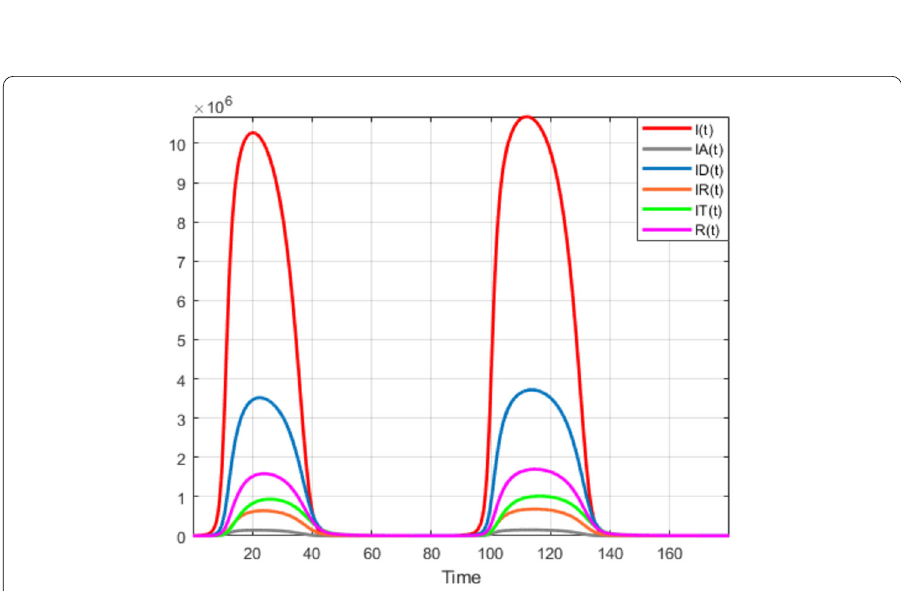
Figure 30 Numerical visualization of COVID-19 model for α = 0.90, β = 0.85